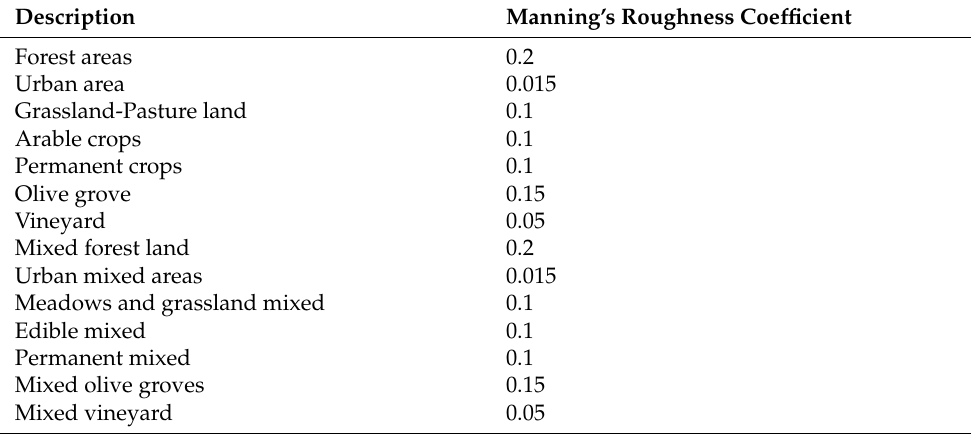
Table 1. Land cover and roughness coefficient by Manning (Ilot, Greece,